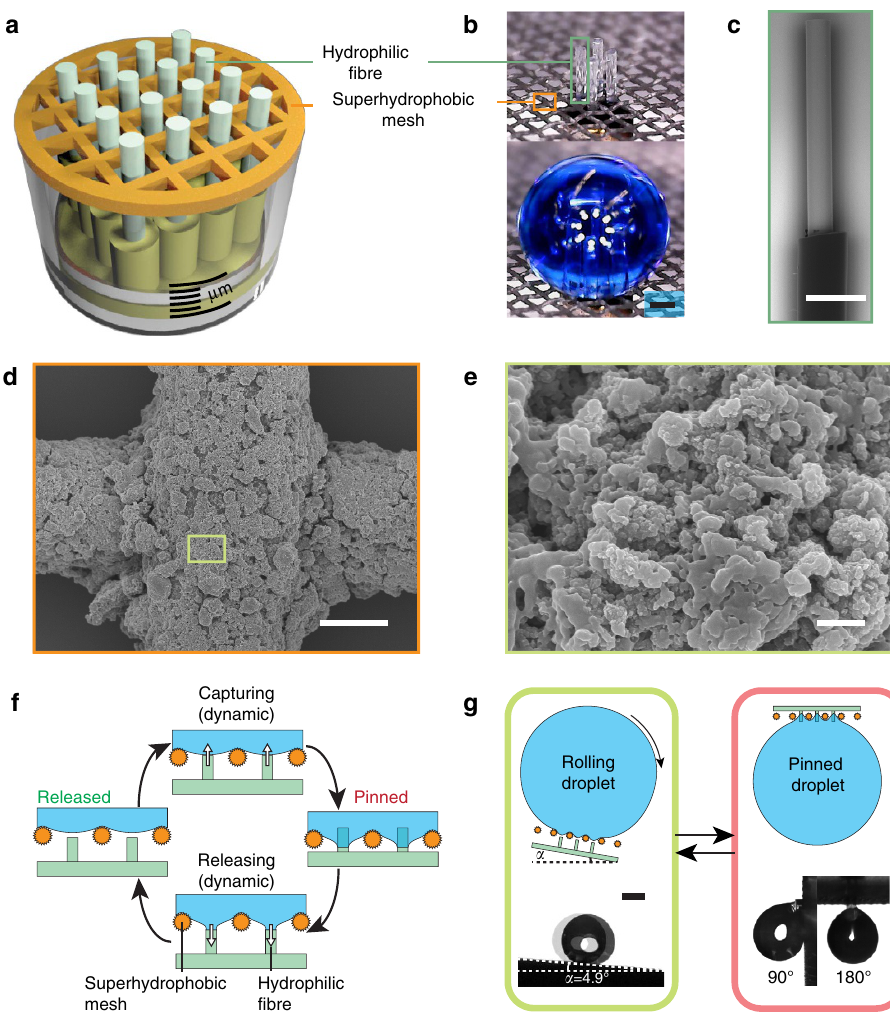
Figure 1 | The design and principle of the MRS. ( a ) Schematic illustration of the assembly of an MRS, which consists of a superhydrophobic mesh and an array of hydrophilic microfibres. ( b ) Optical micrographs showing the structure of a four-fibre MRS; a water droplet (stained blue) is locked onto the MRS. Scale bar, 300 m m. Scanning electron microscopy images of ( c ) a hydrophilic microfibre wrapped in a protective jacket, scale bar, 300 m m; ( d ) a superhydrophobic mesh coated with graphene nanoplatelets, scale bar, 30 m m; and ( e ) a typical magnified region in ( d ), scale bar, 500nm. ( f ) A side-view schematic illustration of the mechanism of the MRS: the hydrophilic array (green) advances towards the superhydrophobic mesh (orange) (Capturing) until the array protrudes from the pores of the mesh, at which time the water droplet is pinned (Pinned); when the array is retracted through the mesh (Releasing), the surface returns to its non-wettable state, allowing the water droplet to roll (Released). ( g ) Schematic illustrations and optical micrographs showing the rolling and pinned states, respectively, of a water droplet on an MRS. Scale bar,